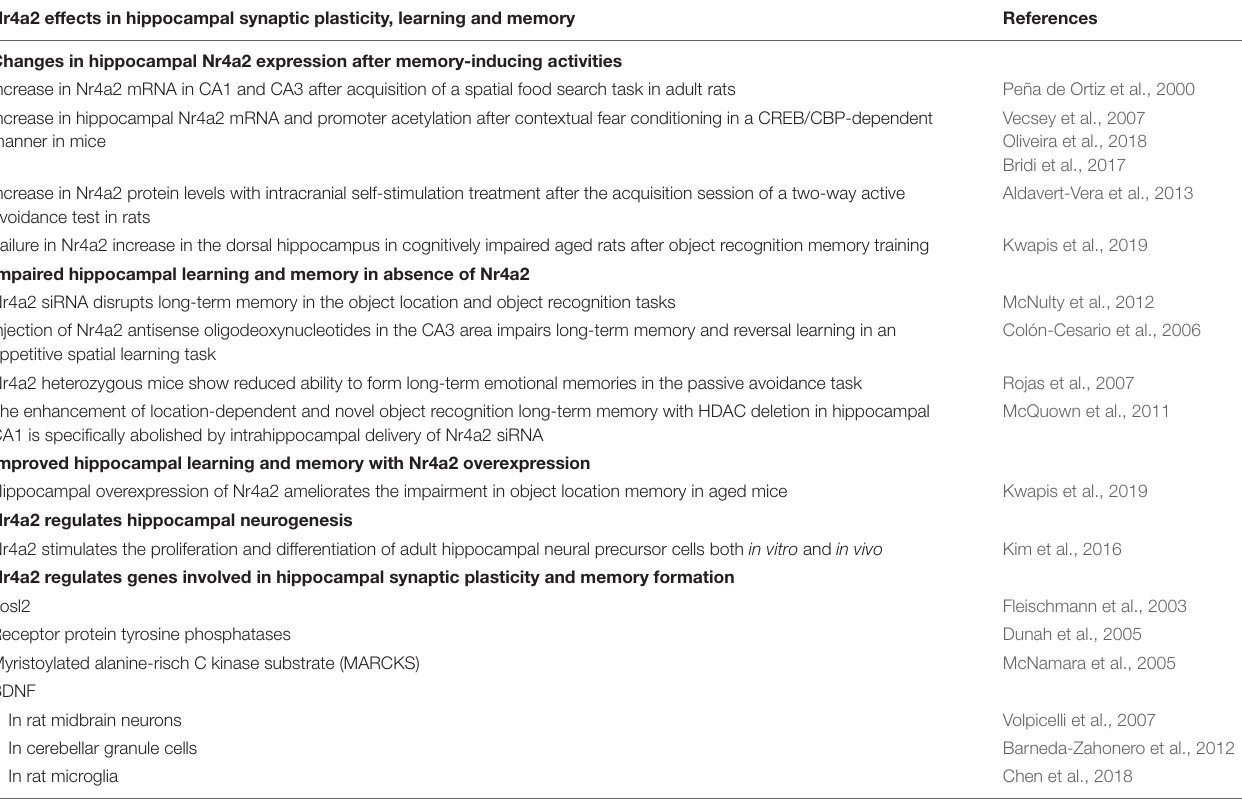
TABLE 1 | Overview of the overall effects of Nr4a2 in hippocampal synaptic plasticity, learning and memory. Nr4a2 effects in hippocampal synaptic plasticity, learning and